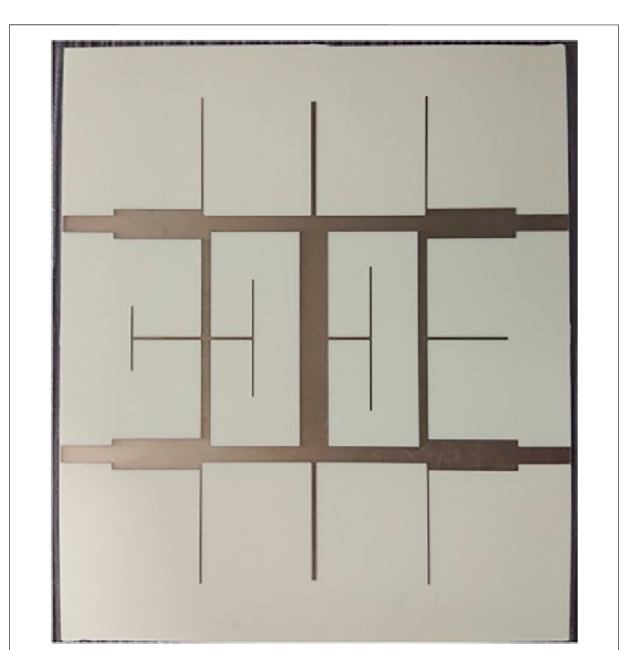
FIGURE 13 | Photograph of the fabricated dual-wideband balanced